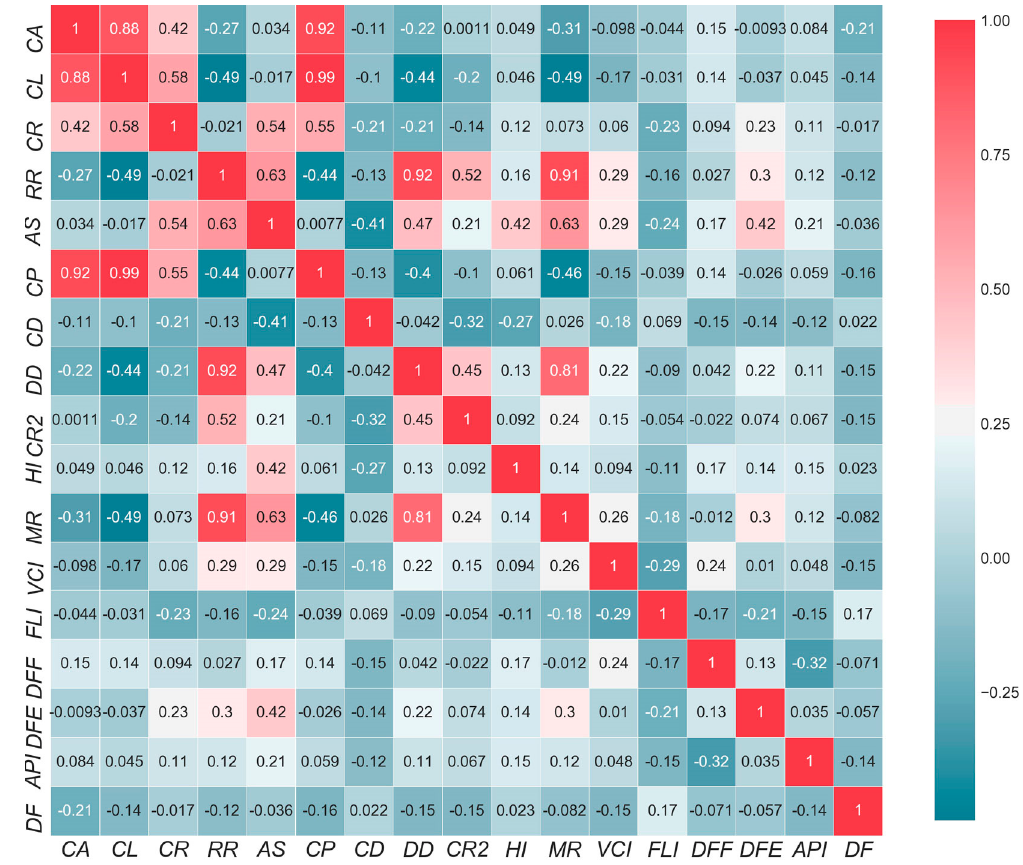
Figure 5. Heat map of the parameter correlation matrix.